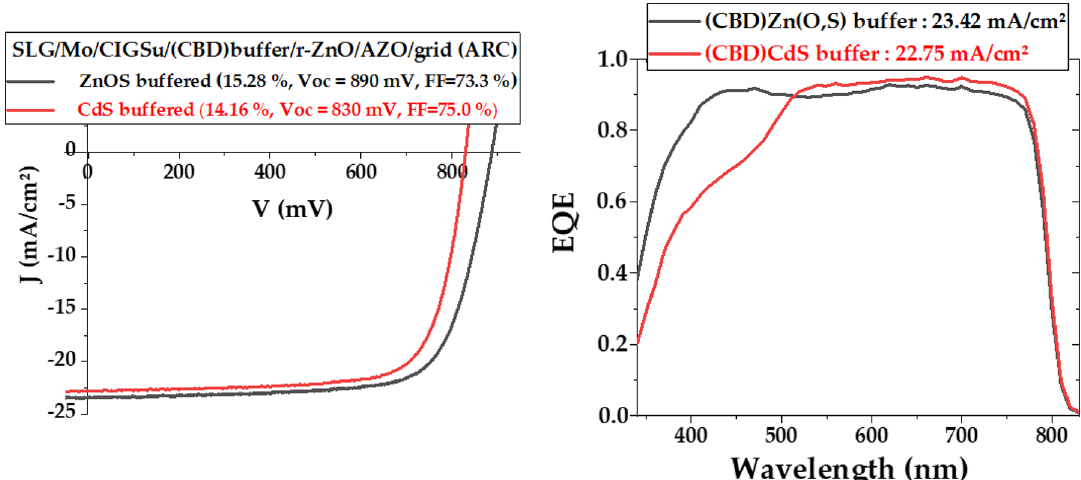
Fig. 7. JV characteristics and EQE (with ARC) of the best solar cell buffered with either (CBD)CdS (in red) or with (CBD)Zn(O,S) (in